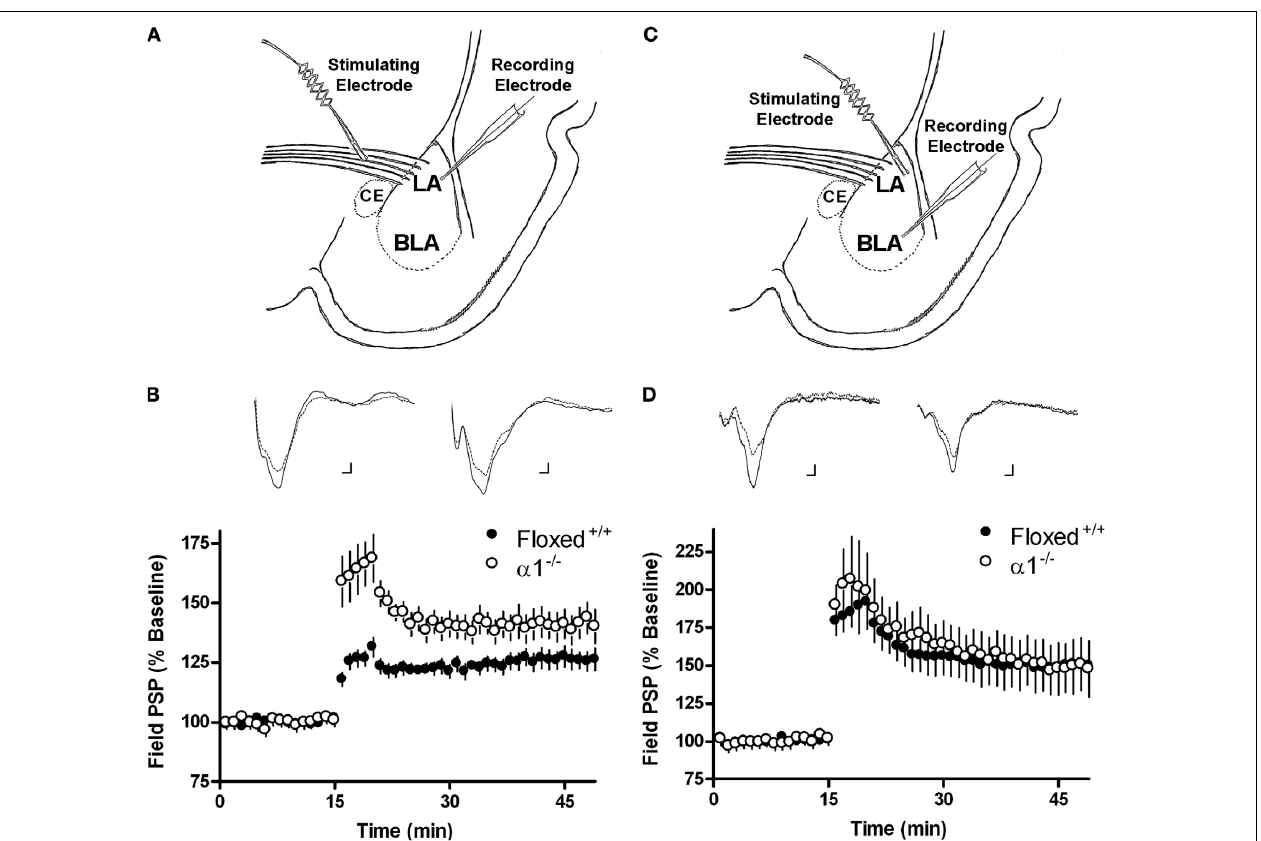
(C) Schematic describing the electrode placement for experiments involving the LA-BLA pathway. (D) The amount of basolateral amygdala activity-dependent plasticity induced by 100 Hz stimulation of the LA-BLA pathway in slices from fl oxed + / + (black circles) and α 1 − / − (white circles) mice. Inset shows sample extracellular traces elicited during baseline (smaller response) and 25–30 min after 100 Hz stimulation in slices from fl oxed + / + (left side of panel) and α 1 − / − mice (right side of panel). Calibration bars: 1 ms, 0.1